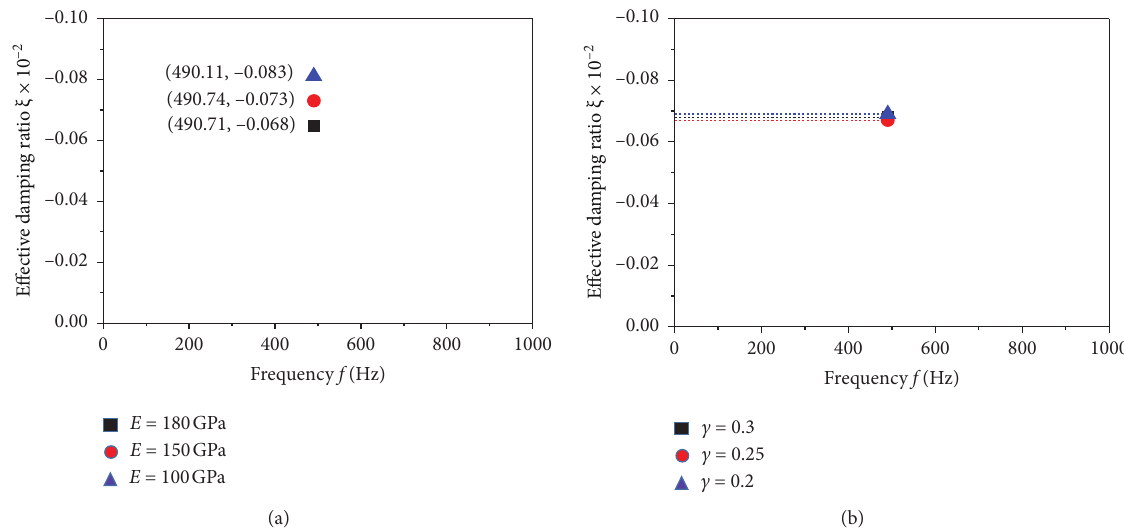
Figure 10: Effect of different material parameters of the brake pad on the frictional self-excited vibration of the wheelset-track system: (a) effect of different Young’s modulus and (b) effect of different Poisson’s